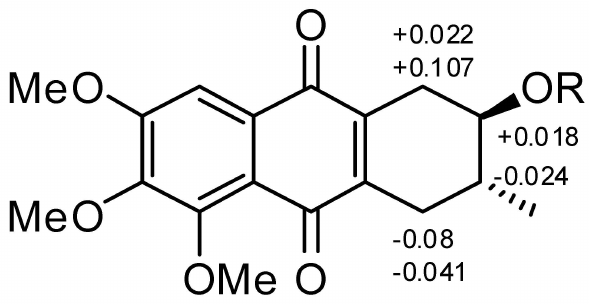
Figure 5. ∆ δ ( δ S - δ R ) values (in ppm) for the MTPA esters of 1 . 1 a R = (S)-MTPA; 1 b R = (R) ´